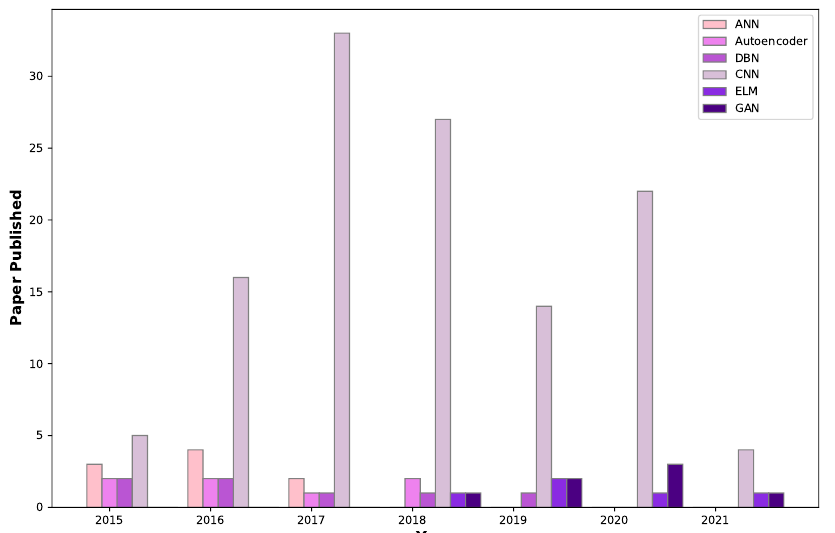
Figure 2. This figure shows the published number of deep-learning-based breast cancer studies in the past 6 years and the current